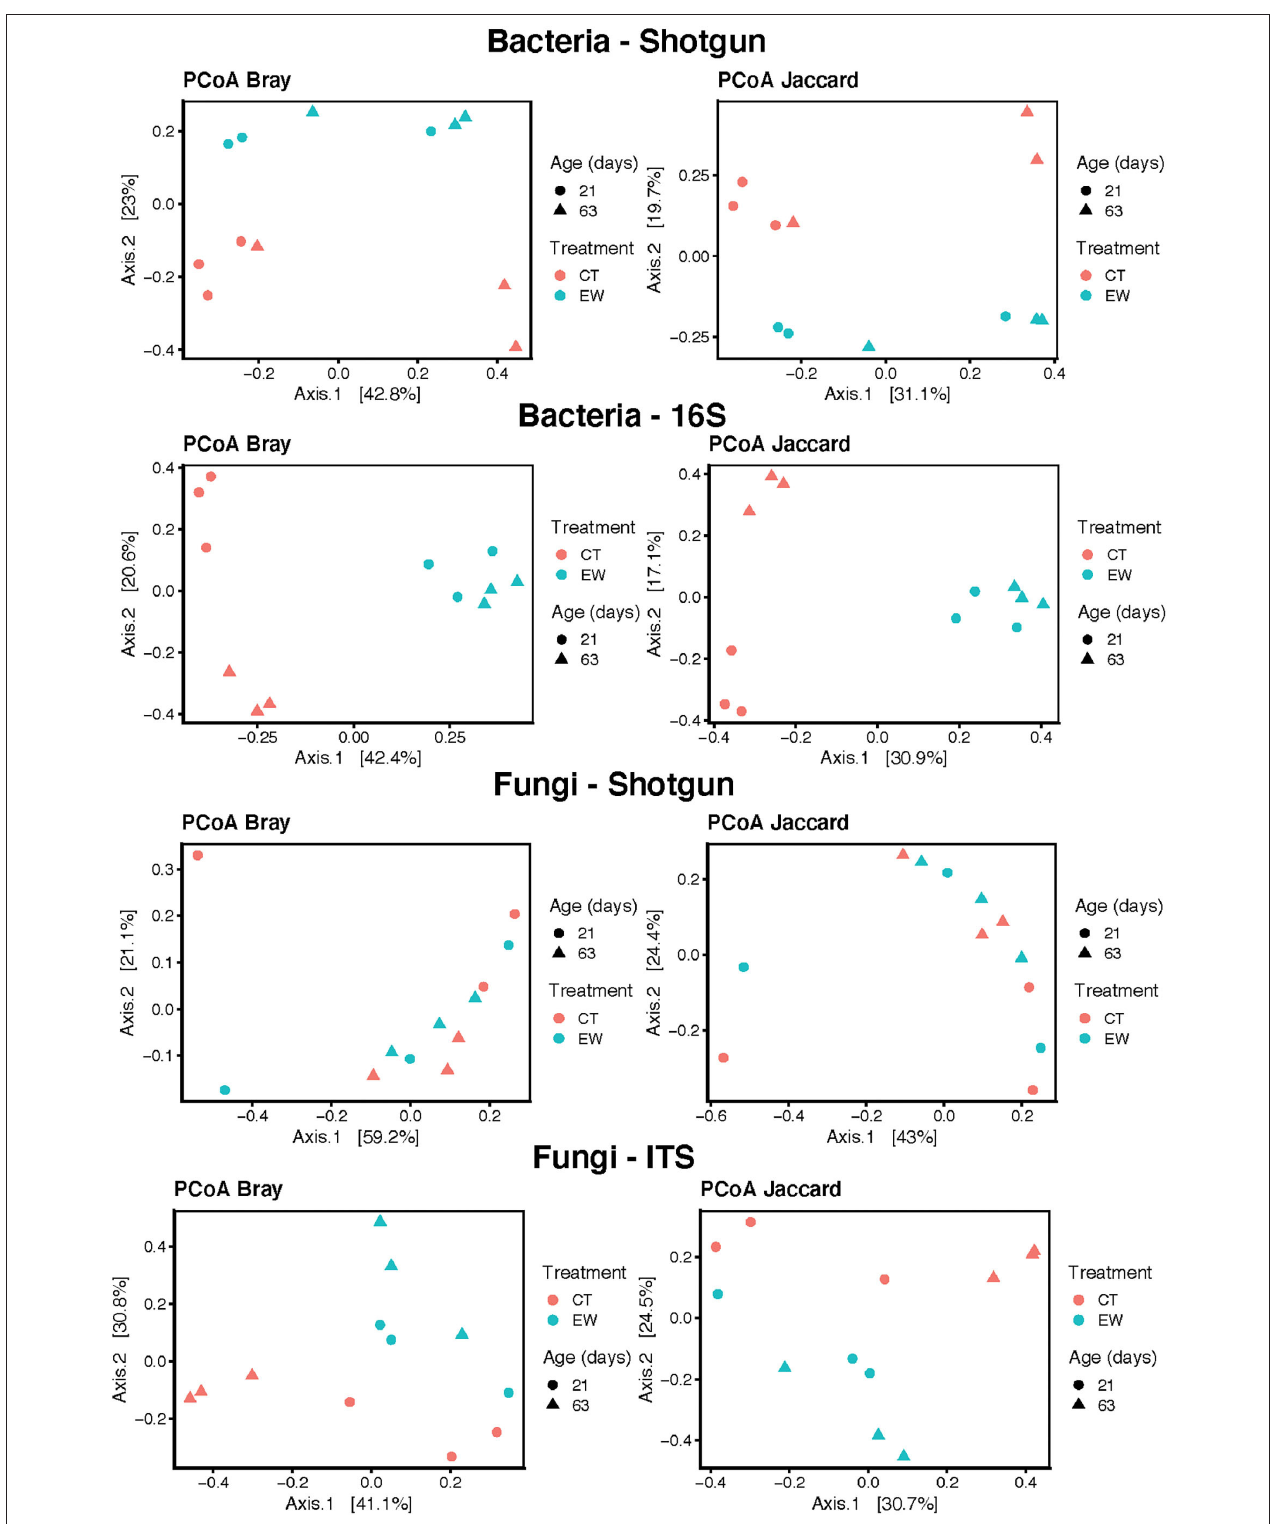
FIGURE 3 | Bacterial PCoA plots of beta-diversity estimates (Bray-Curtis and Jaccard indices) for treatment (control, CT; earthworm, EW) and age (21 and 63 days) groups for shotgun metagenomic and 16S metataxonomic strategies.